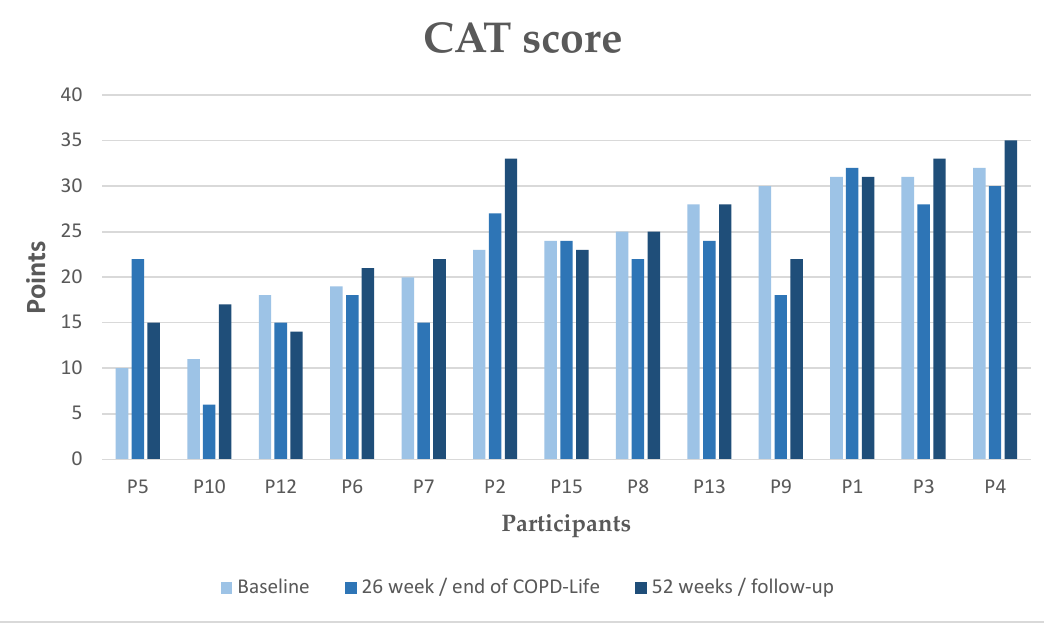
Figure 5. Participant’s results in COPD Assessment Test (CAT) score before and after >C PD-Life>> and at a 52-week follow-up, ordered after baseline results (from lowest to highest). Two patients, P11 and P14, did not fulfil the questionnaire correctly so their data is excluded.